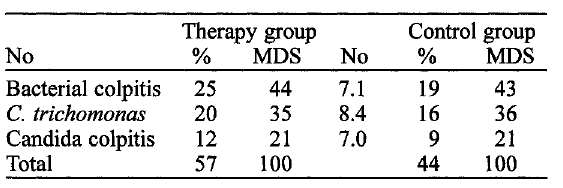
Results: Table 1. Distribution of a type of recidivant colpitis and mean discomfort scores (MDS) before treatment in the therapy and control